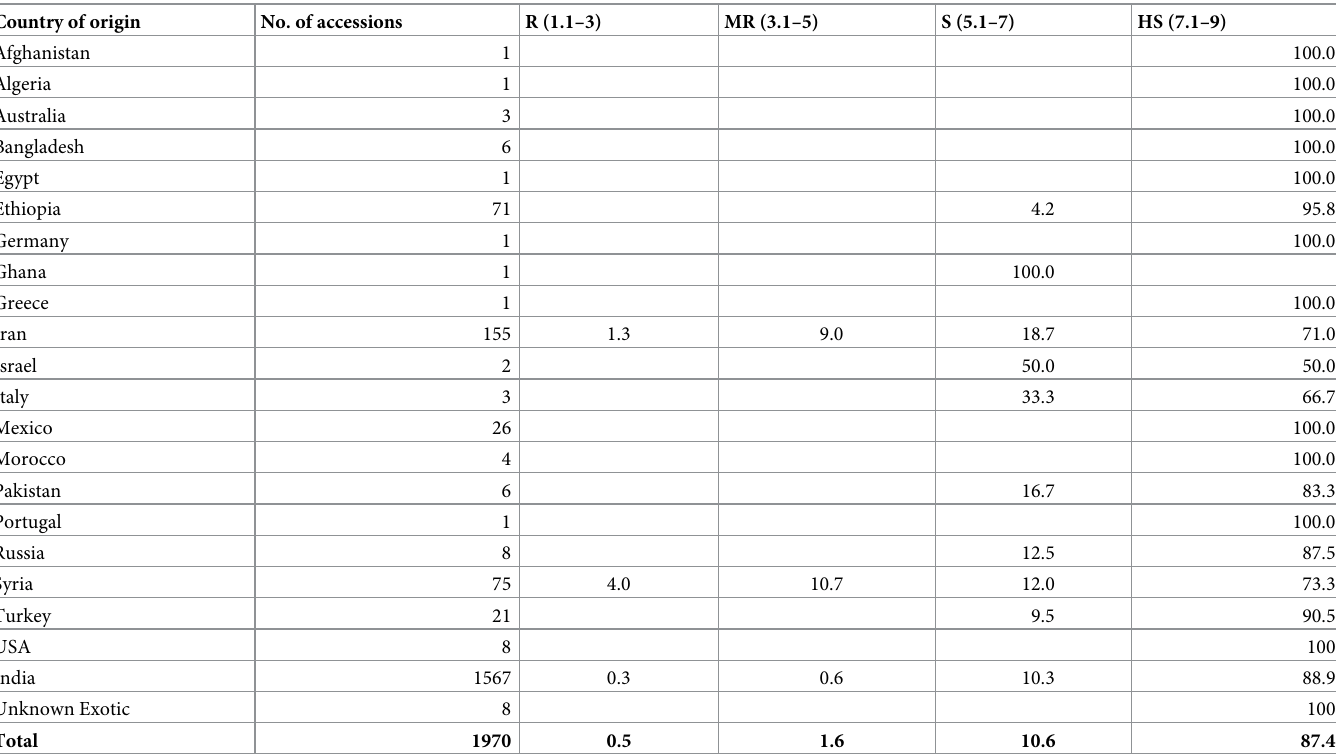
Table 1. Classification of chickpea germplasm based on their origin and disease severity frequency. Country of